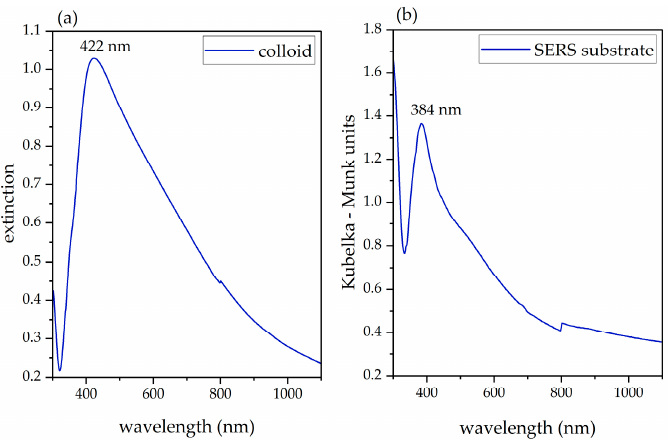
Figure 1. ( a ) UV-Vis extinction spectrum of the concentrated Lee-Meisel silver colloid (diluted 1:50 in distilled water to avoid optical saturation). ( b ) UV-Vis diffuse reflectance spectrum of one of the paper sensors produced by centrifugation (Section 2.2) after Kubelka-Munk conversion.